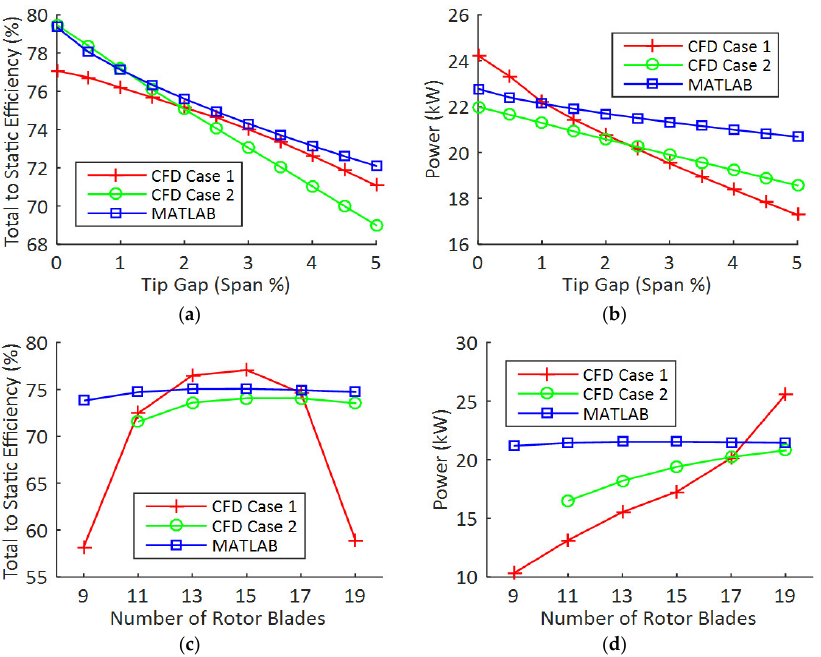
Figure 12. MATLAB algorithm validation for ( a , b ) tip gap prediction ( c , d ) blade number prediction.